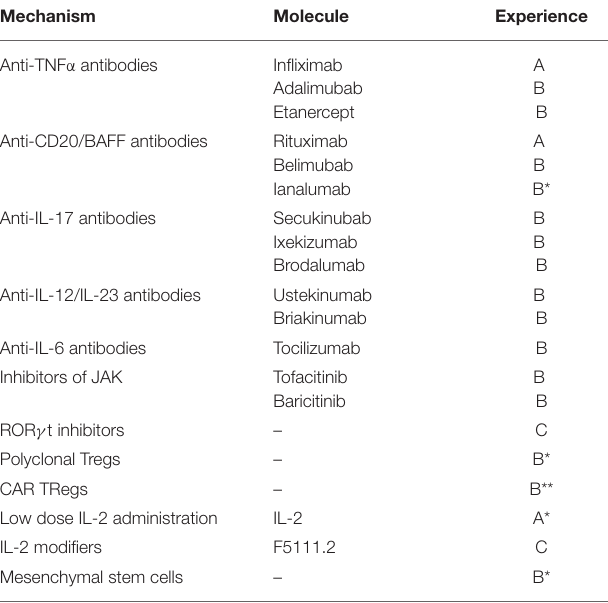
TABLE 1 | Potential approaches for immunoterapy of AIH